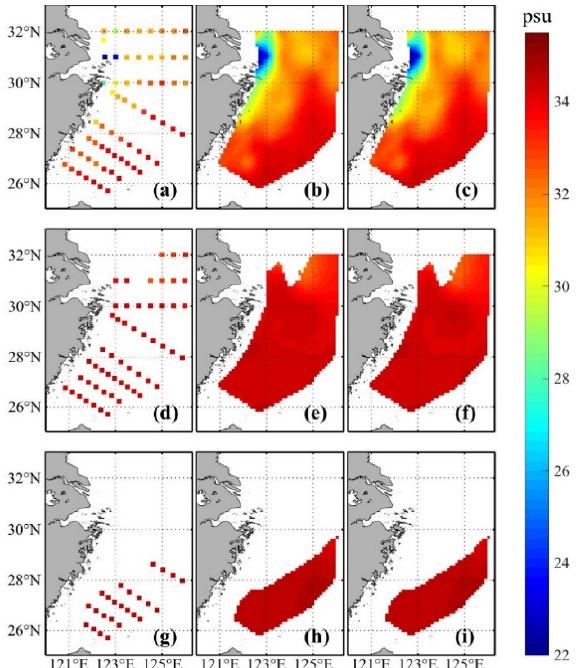
Figure 9. The in situ salinity (summer 2011) and reconstructed results with different RBFs in the ECS shelf. The first column presents the original in situ observations, the second is the interpolation result using the thin plate spline RBF method, and the last column uses the cubic RBF method. ( a–c ) − 5 m depth; ( d–f ) –45 m depth; and ( g–i ) − 85 m